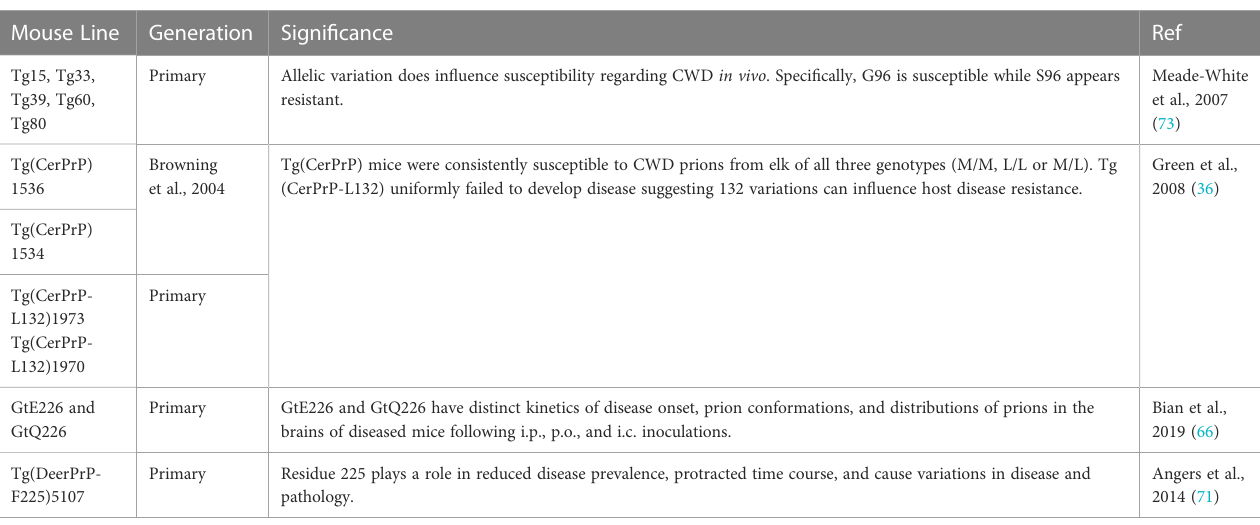
TABLE 5 Transmission concerning genetics. Mouse